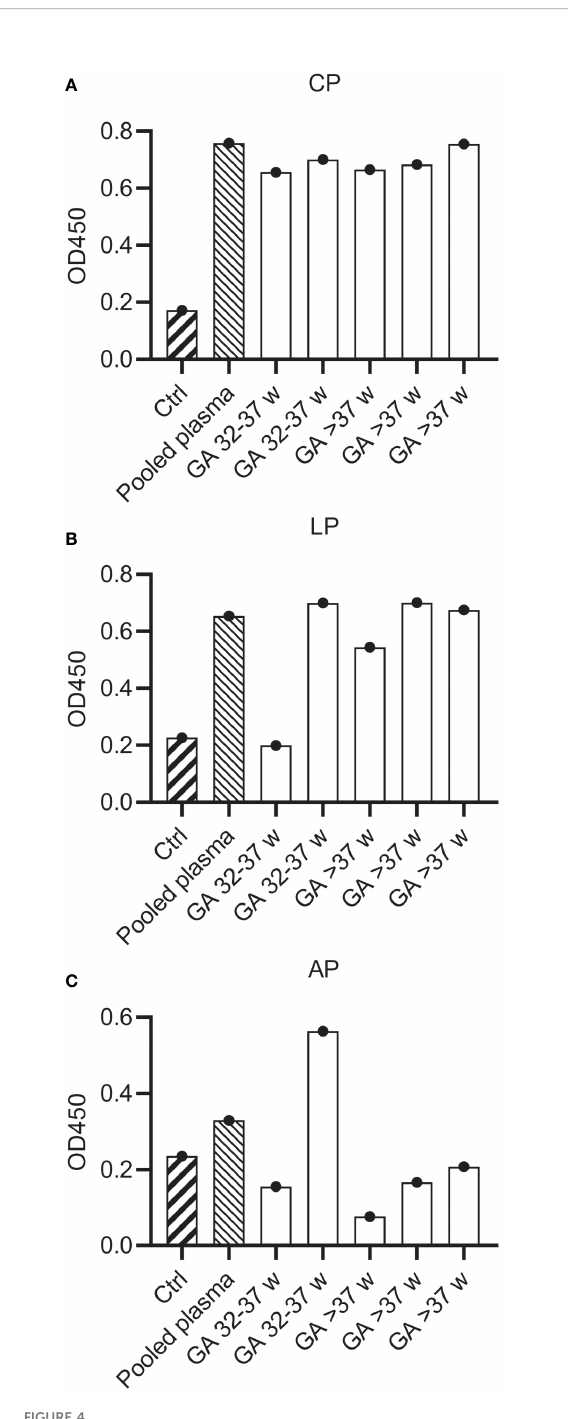
FIGURE 4 Complement activity of neonatal plasma. Complement activity in pooled human hiridun plasma and neonatal hirudin plasma (n=5) was determined in complement ELISAs, detecting deposition of C3b. Plates were coated with (A) IgM and 2% plasma to determine CP activity, (B) mannan and 2% plasma to determine LP activity and (C) LPS and 30% plasma to determine AP activity. Ctrl wells were uncoated and incubated with pooled adult plasma. CP, Classical pathway; LP, Lectin pathway; AP, Alternative